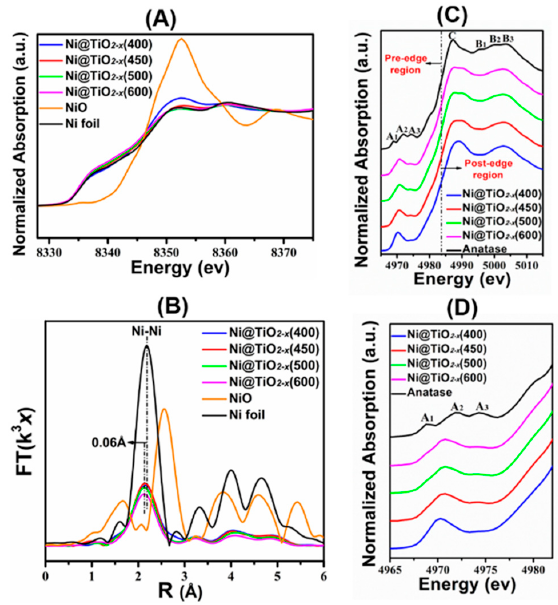
Figure 8. ( A ) Normalized XANES spectra at Ni K-edge for Ni@TiO 2 − x (400), Ni@TiO 2 − x (450), Ni@TiO 2 − x (500), and Ni@ TiO 2 − x (600), respectively. ( B ) Fourier-transform EXAFS spectra at Ni K-edge for NiO reference, Ni@TiO 2 − x (400), Ni@TiO 2 − x (450), Ni@TiO 2 − x (500), Ni@TiO 2 − x (600), and Ni foil, respectively. ( C ) Normalized XANES spectra at Ti K-edge for Ni@TiO 2 − x (400), Ni@TiO 2 − x (450), Ni@TiO 2 − x (500), andNi@TiO 2 − x (600), respectively. ( D )Theenlargedviewoftheabsorptionedgeselected from (C). Reprinted with permission from Reference [54]. Copyright 2017, American Chemical